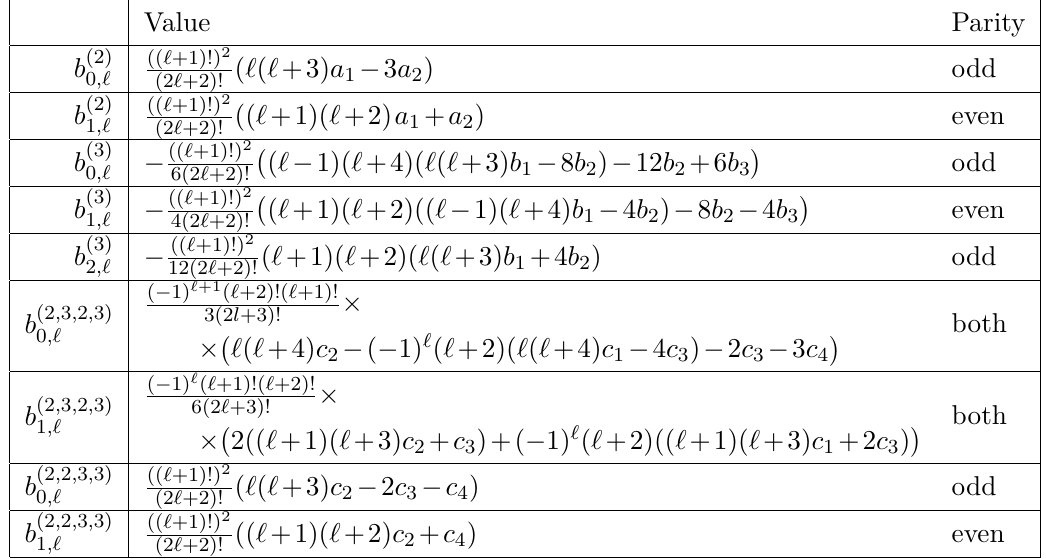
Table 2. Coefficients b n,‘ for the expansion of ˆ f functions in atomic blocks. The last column refers to the parity of ‘